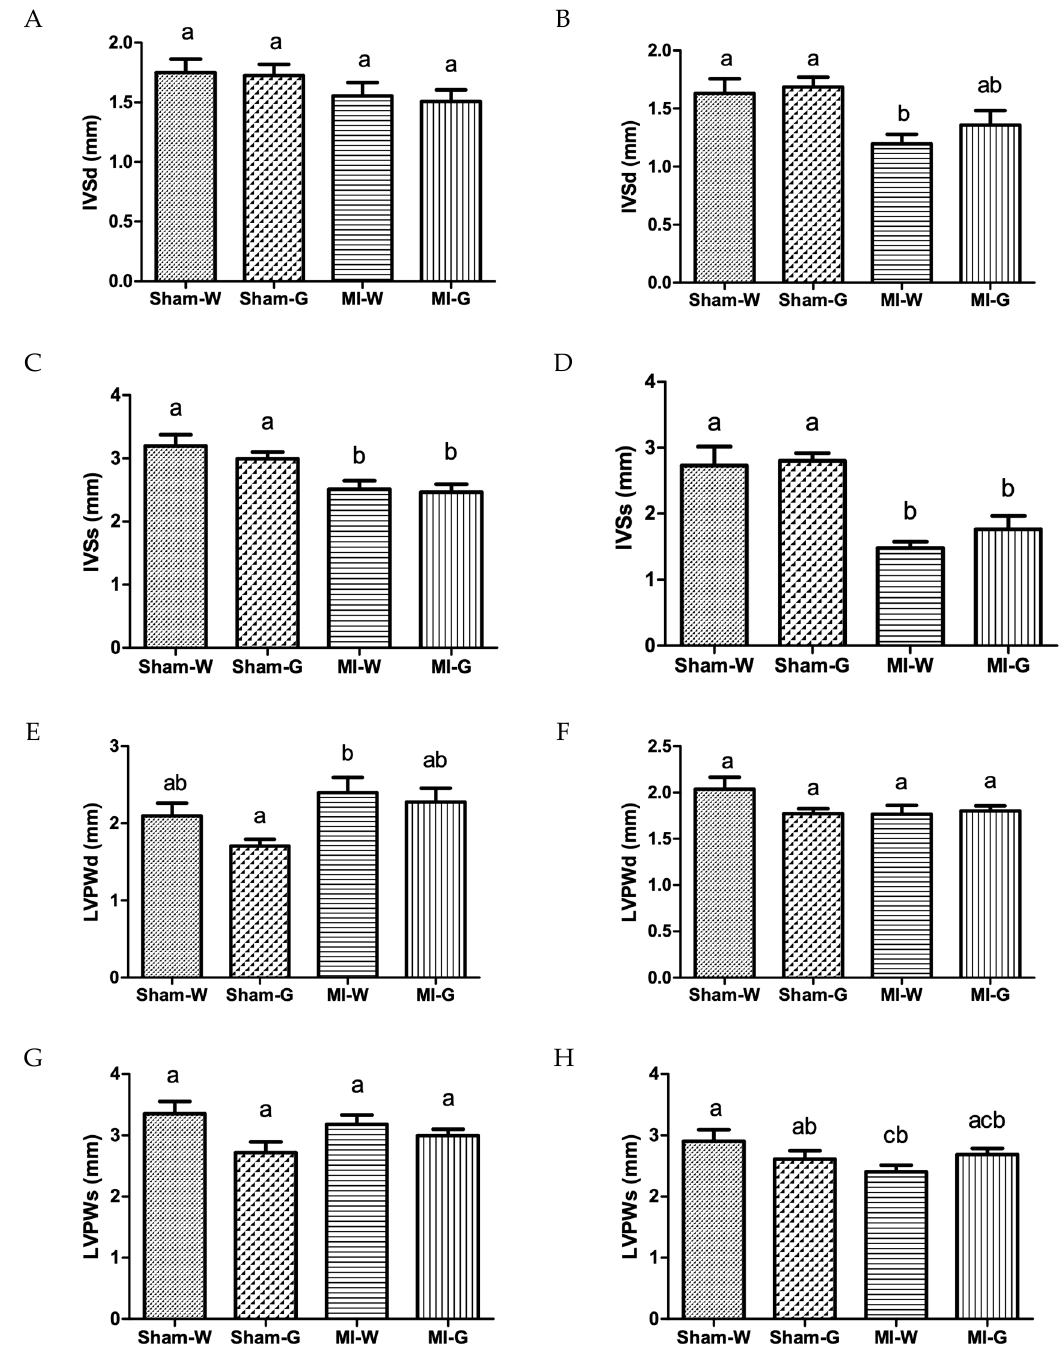
Figure 2. Effect of ginseng berry extract on cardiac hypertrophy. ( A ) Interventricular septal thickness at diastole (IVSd) at 4 weeks; ( B ) IVSd at 8 weeks; ( C ) IVS at systole (IVSs) at 4 weeks; ( D ) IVSs at 8 weeks; ( E ) LV posterior wall thickness at diastole (LVPWd) at 4 weeks; ( F ) LVPWd at 8 weeks; ( G ) LV posterior wall thickness at systole (LVPWs) at 4 weeks; ( H ) LVPWs at 8 weeks. Values presented are mean ± SEM. Bars with differing letter are significantly different, p < 0.05. Sham-W: Sham MI treated with distilled water ( n = 8); Sham-G: Sham MI treated with GBE 150 mg/kg/body weight/day ( n = 8); MI-W: MI treated with distilled water ( n = 12–14); MI-G: MI treated with GBE 150 mg/kg/body weight/day ( n = 12 – 14).